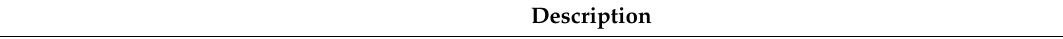
Table 2. Description of the behavioral events recorded during the sightings of Risso’s dolphin occurring in the Gulf of